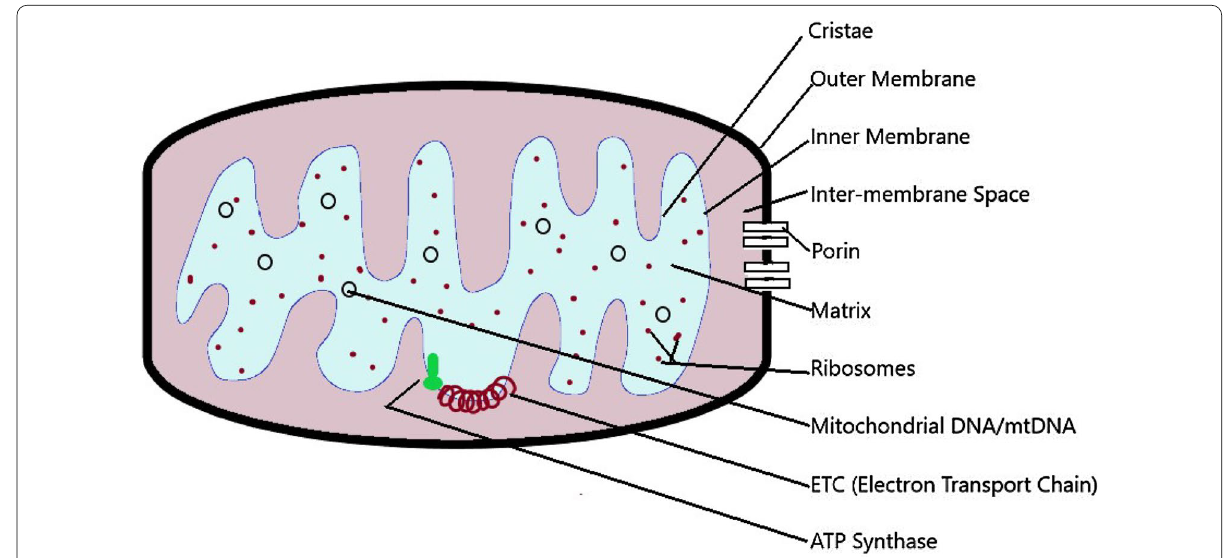
Fig. 1 Structure of a